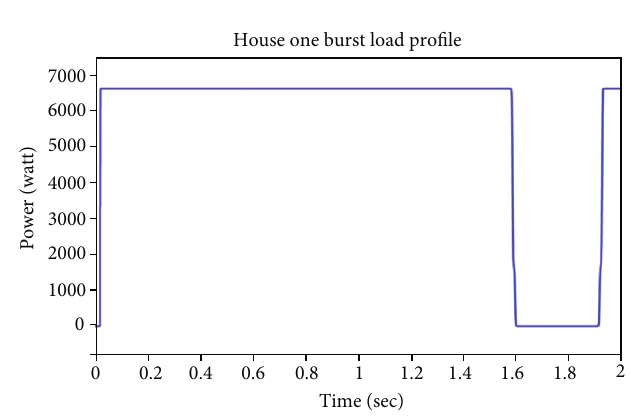
Figure 33: Burst load pro fi le of house one.